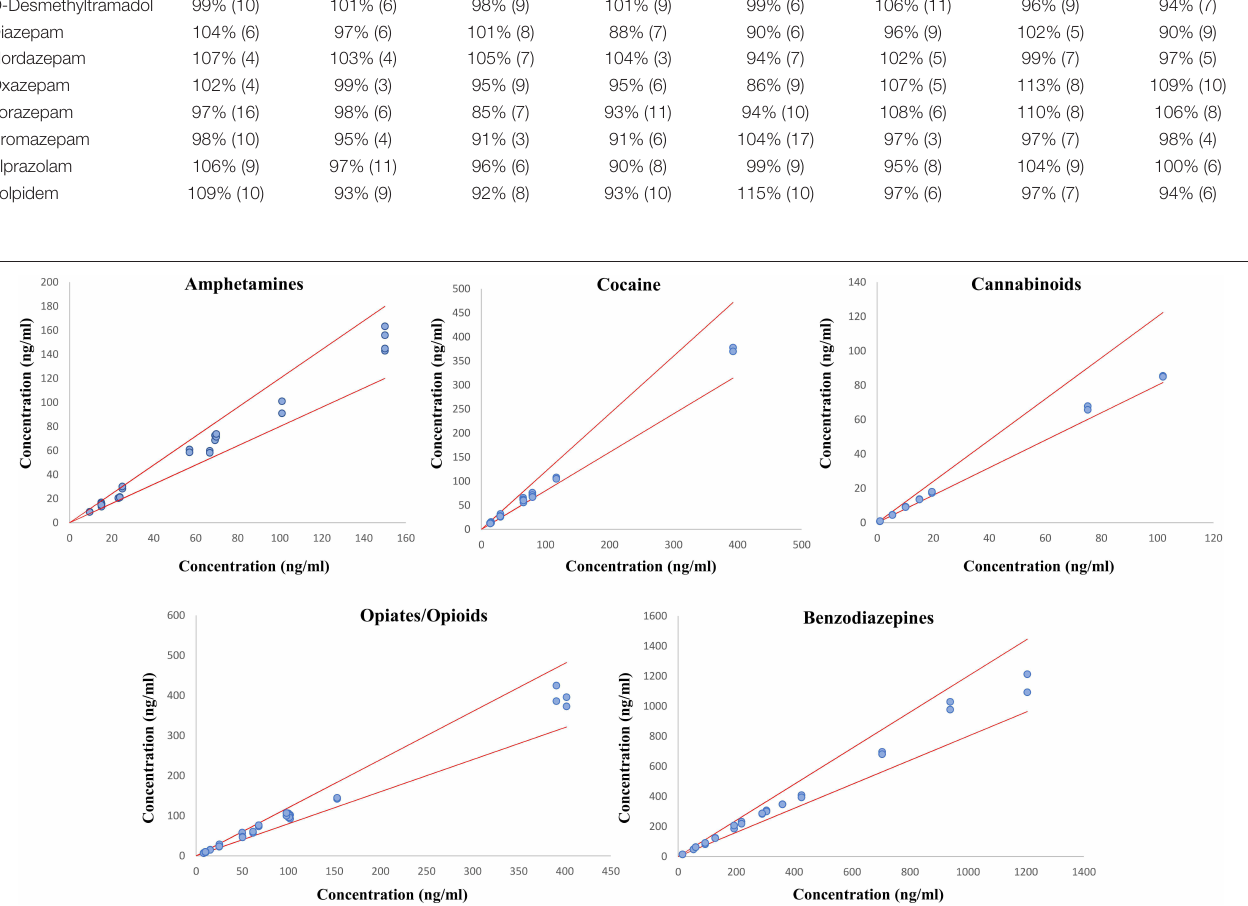
FIGURE 3 | Method evaluation by comparing measured values and targeted commercial EQCs values. PRM measured concentrations are plotted as a function of the expected EQCs concentrations. The red lines represent the ± 20% tolerance